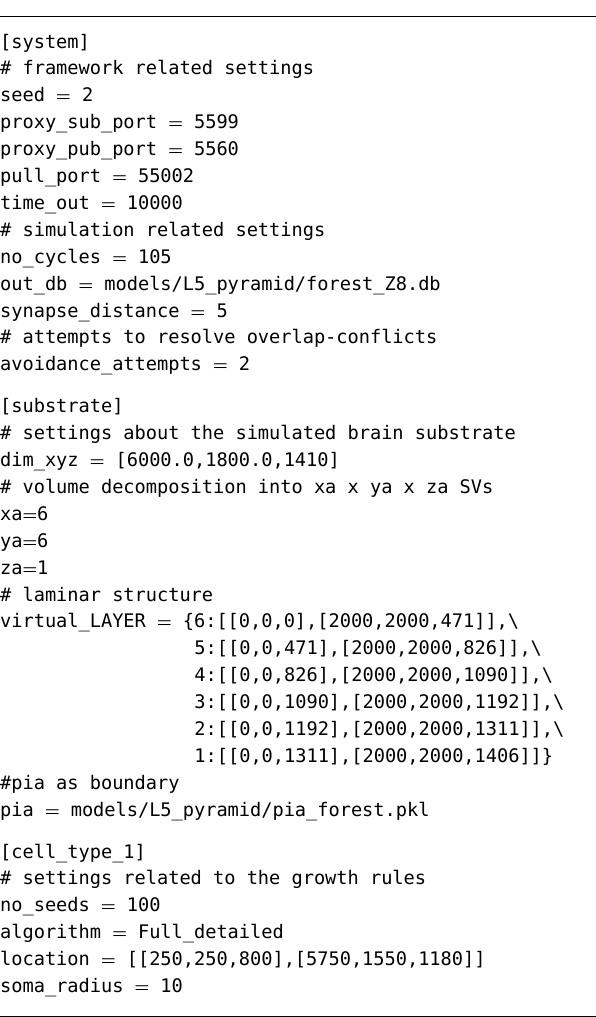
Table 1 | Exemplar configuration file used in